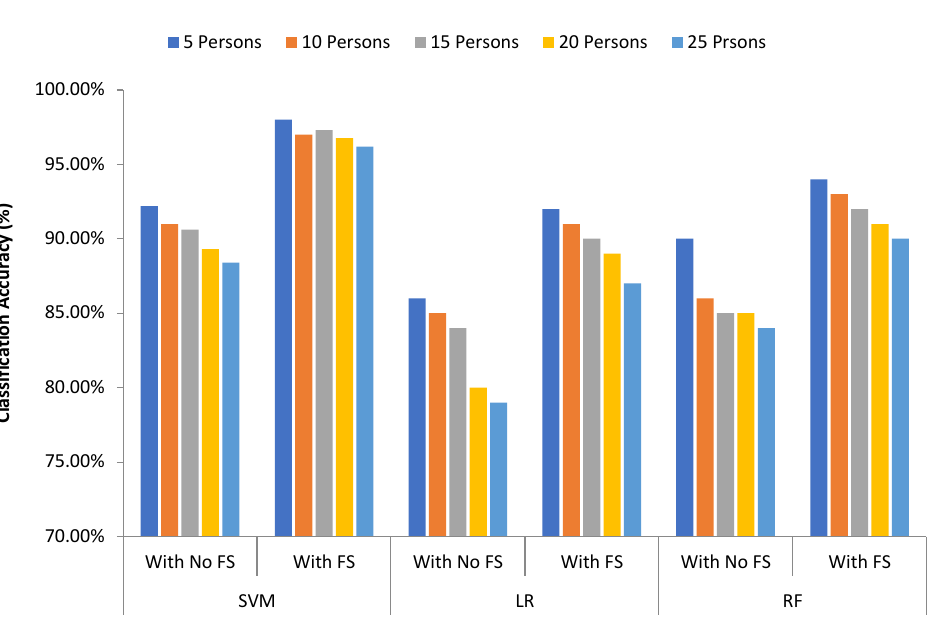
Figure 18. Comparison of accuracy for different classification algorithms with and without FS.